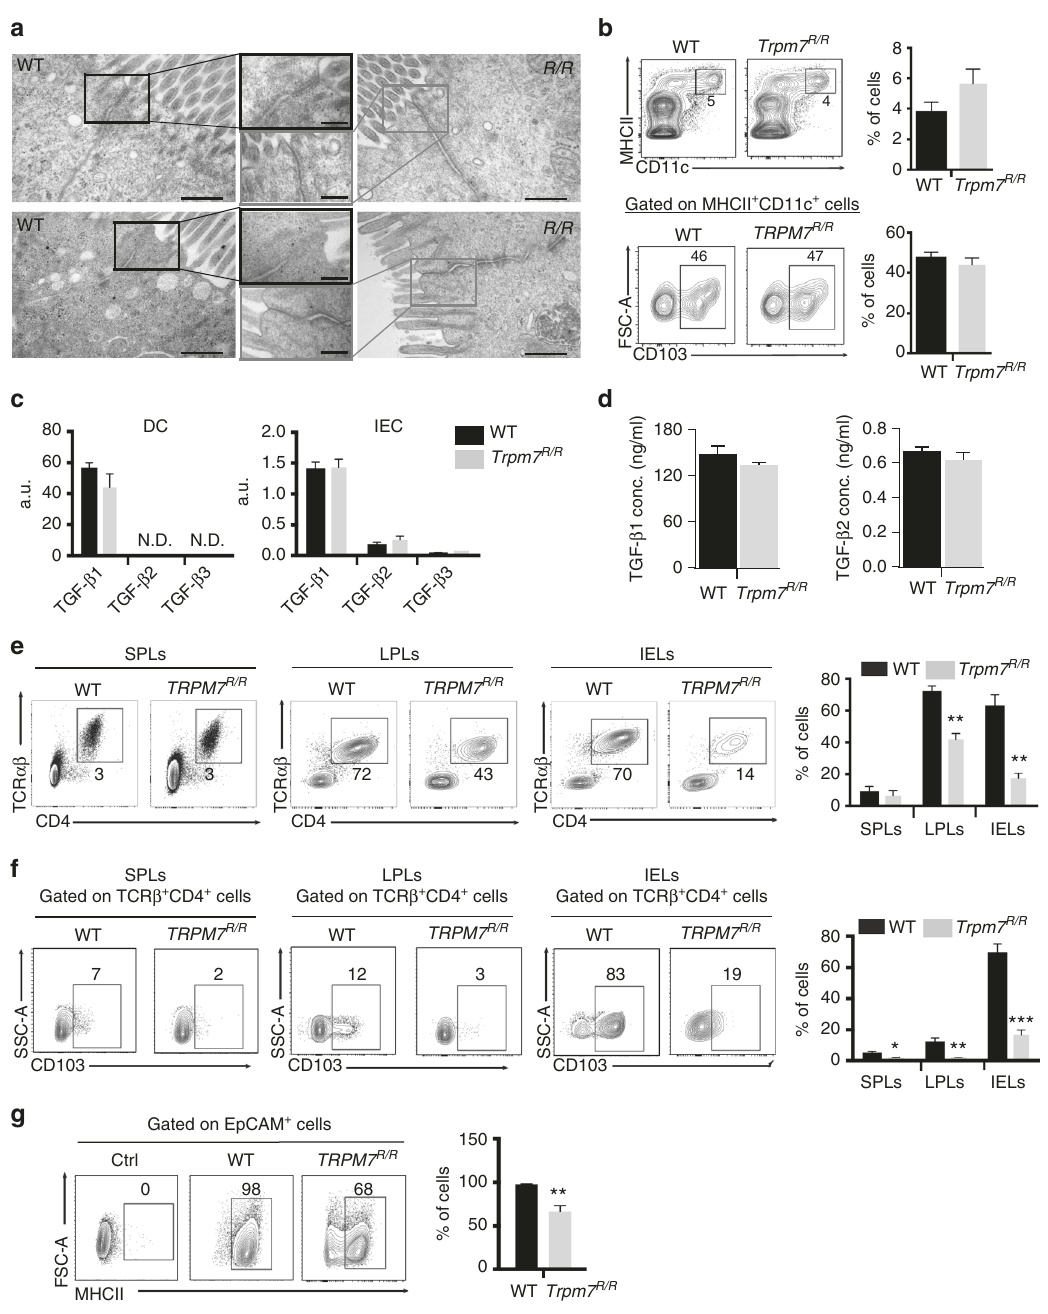
Fig. 4 TRPM7 kinase-dead T cell autonomous defect in in vivo CD103 expression and intra-epithelial localization. a Transmission electron microscopic (TEM) images of small intestine (upper panel) and colon (lower panel) sections from WT or Trpm7 R/R mice. Note no changes in tight junction, adherens junction or desmosome formation between the two genotypes. Scale bars indicate 500 and 200 nm, respectively. b Dot plot (left) and statistical analyses (right) of CD11c + MHCII + DC and relative CD103 expression. Percentages are shown in each gate, bar charts show mean percentages ± s.e.m. ( n = 3). c Quantitative real-time PCR of Tgf- β 1 , Tgf- β 2 and Tgf- β 3 expression in WT or Trpm7 R/R puri fi ed CD11c + MHCII + DC cells (left) or in EpCAM + IEC (right). d TGF- β 1 and TGF- β 2 levels measured in serum harvested from WT or Trpm7 R/R mice ( n = 4). Data are shown as mean ± s.e.m. e Dot plot and statistical analyses of spleen (SPL), lamina propria (LPL) and intra-epithelial (IEL) TCR αβ + CD4 + lymphocytes from Rag1 − / − /Il2rg − / − mice reconstituted with puri fi ed WT or Trpm7 R/R naive CD4 cells. f Cells were gated for surface CD4 and TCR αβ and were analysed for CD103 expression. Percentages are shown in each gate, bar charts show mean percentages ± s.e.m. ( n = 4). g Dot plots and statistical analyses of MHCII expression in EpCAM + intestinal epithelial cells (IEC) from Rag1 − / − /Il2rg − / − mice reconstituted with puri fi ed WT or Trpm7 R/R naive T cells. Percentages are shown in each gate, bar charts show mean percentages ± s.e.m. ( n = 4). Data are representative results of at least three independent experiments. A two-tailed Student ’ s t test was used with * p < 0.05; ** p < 0.01 and *** p <